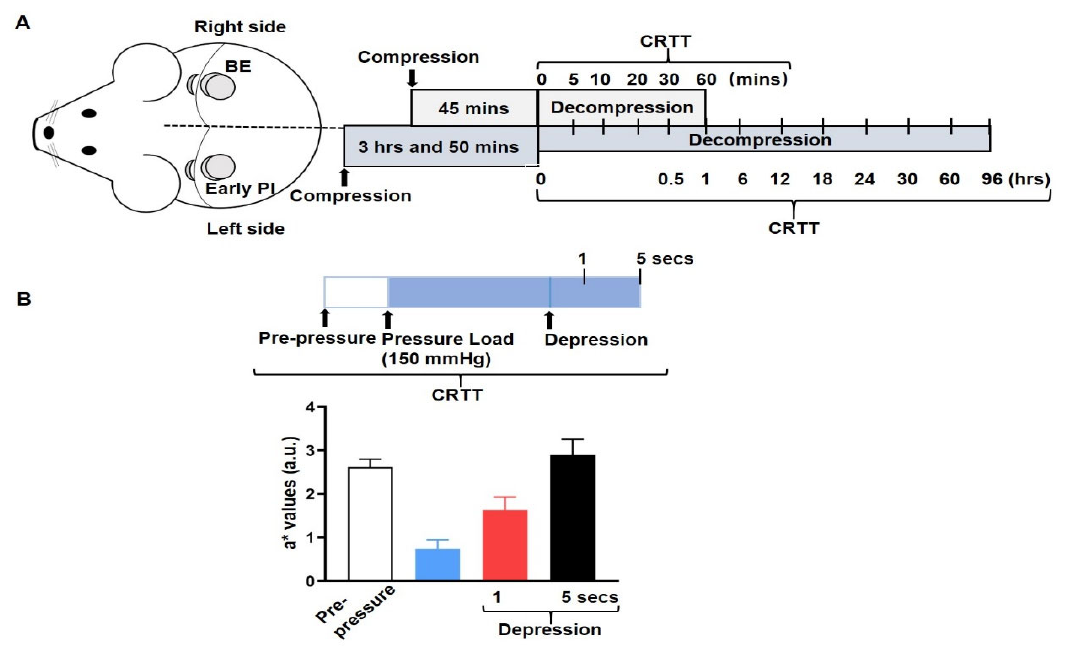
Figure 2. Assessment of ischemia: ( A ) illustration of the procedure for the capillary refill time test (CRTT); ( B ) the CRTT was performed after the transparent disc method by applying temporary pressure (150 mmHg) on the erythema after depression in the BE and early PI group (upper). The a* values represent the blood flow of the following periods: blank indicates pre ‐ pressure, red color indicates 1 s after depression, and black color indicates 5 s post ‐ depression (bottom).